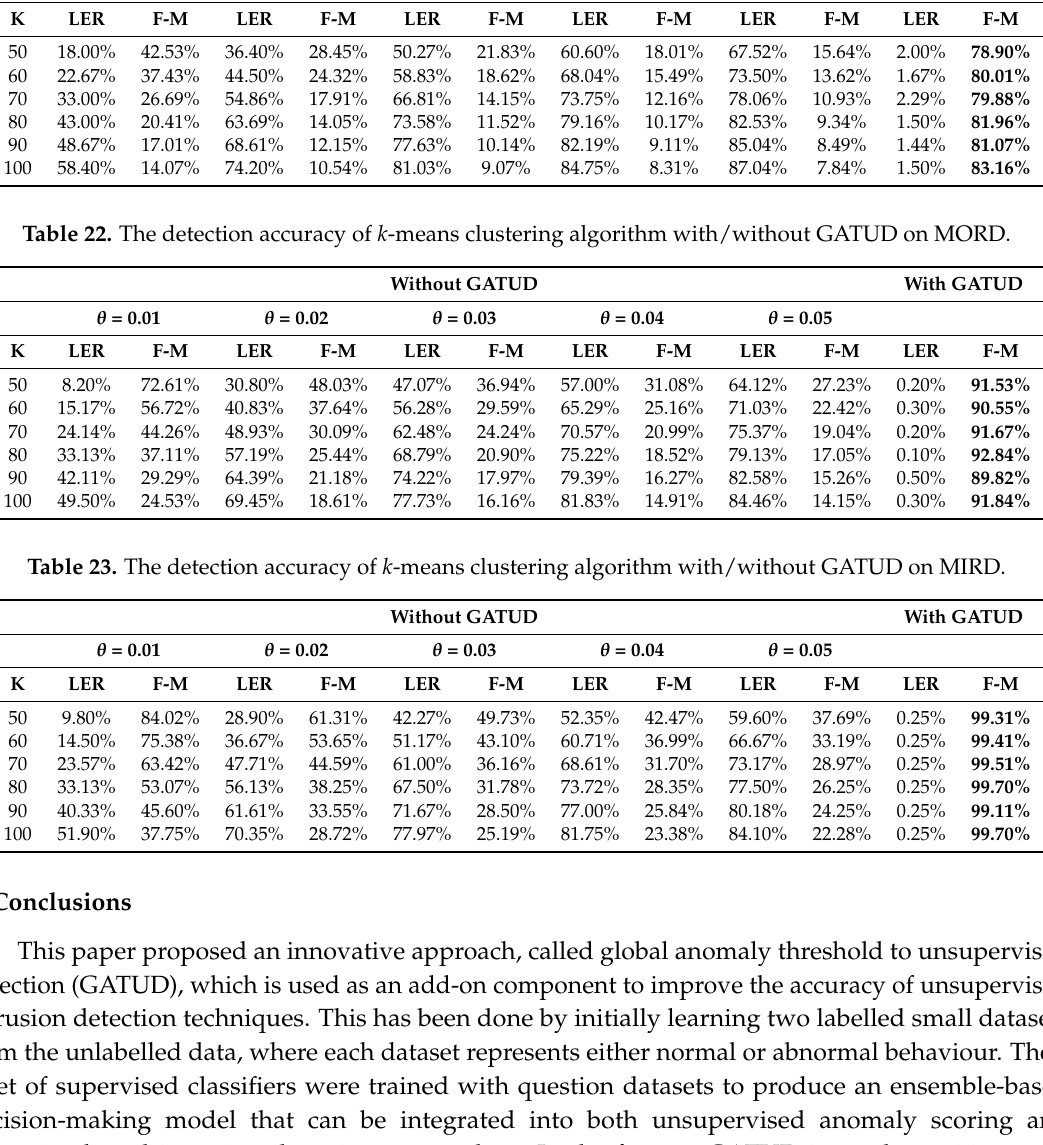
Table 21. The detection accuracy of k -means clustering algorithm with/without GATUD on SORD. Without GATUD With GATUD θ = 0.01